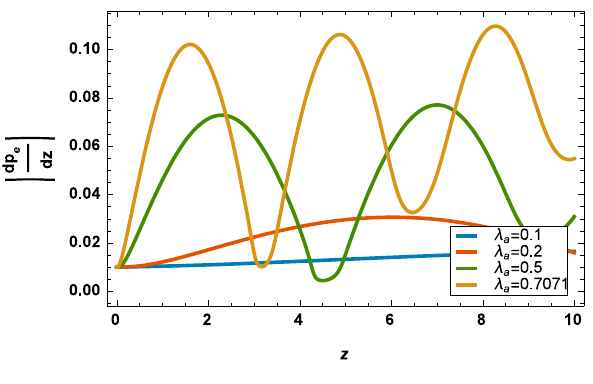
Fig. 5 Pressure Gradient along Tapered Tube for Various Values of λ a with α = 20 , β = 0 . 5